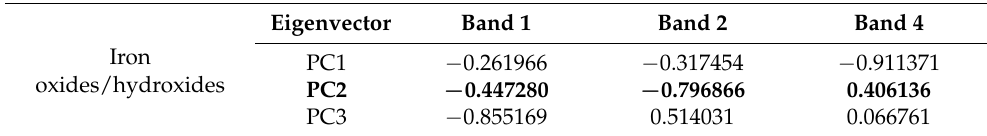
Table 2. Eigenvector matrix of the iron oxides/hydroxides calculated using SPCA method for ASTER bands 1, 2, and 4.